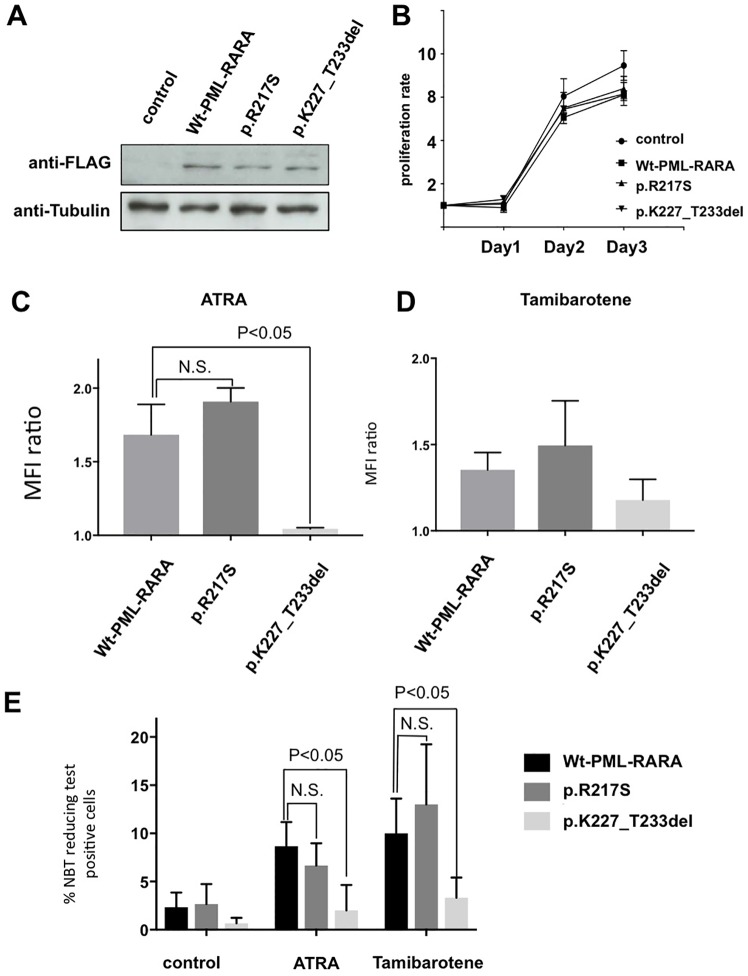
The deletion mutation abrogates RA-induced APL cell differentiation.(A) The expression of PML-RARA protein was examined by Western blot analysis with anti-FLAG antibody in established Wt-PML-RARA and mutant- PML-RARA expressing cells. (B) Cell growth assay in established Wt-PML-RARA and mutant-PML-RARA expressing cells. (C, D) Mean fluorescence intensity (MFI) ratios of CD11b to isotype controls in ATRA- (C) and tamibarotene- (D) treated Wt-PML-RARA and mutatnt-PML-RARA expressing cells. The cells were treated with 1 μM of ATRA or tamibarotene for seven days. Error bars represent mean values ± S.D. of at least three independent experiments. (E) Frequencies of NBT reduction of neutrophils. Cells were treated with 1 μM ATRA or tamibarotene for seven days. Error bars represent mean values ± S.D. of at least three independent experiments.